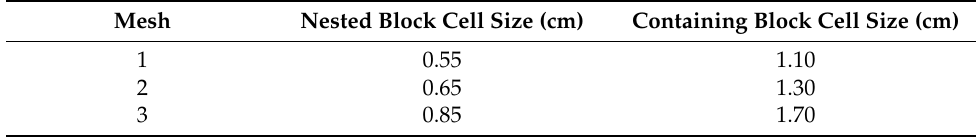
Table 5. The numerical results of mesh convergence